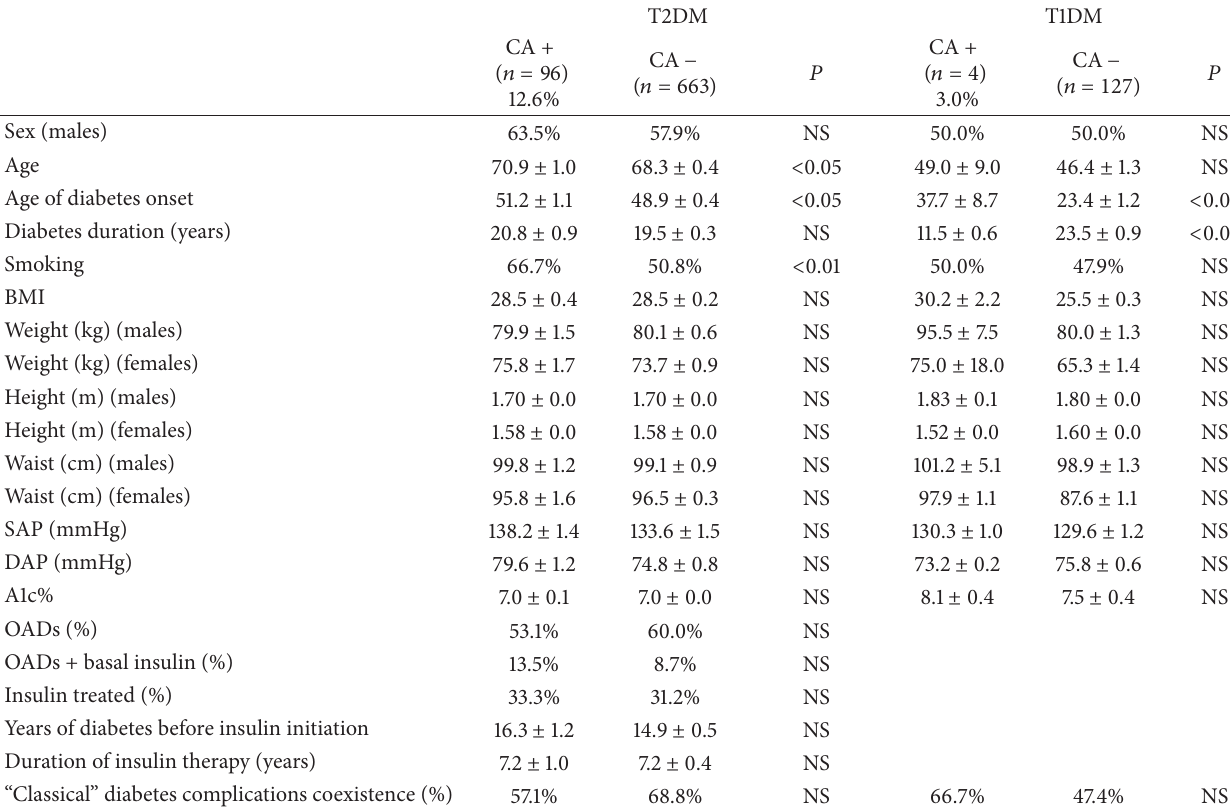
Table 1: Characteristics of regularly followed-up subjects with cancer in comparison to subjects without